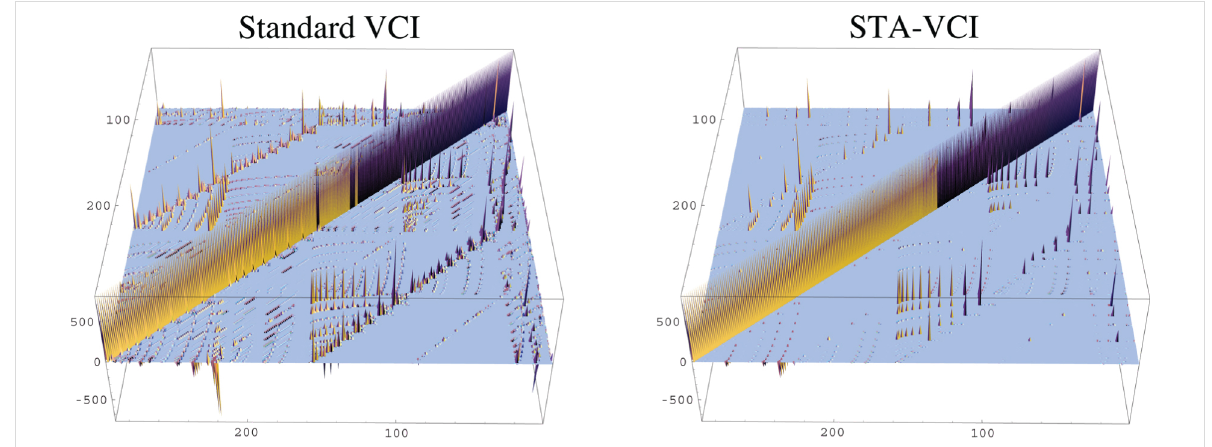
Figure 5: Graphical representation of the VCI matrix elements for a standard VCI and a STA–VCI calculation on methanol using the same basis. For the STA–VCI method, the OH-stretch mode is coupled to all other modes ( N Ã = 1). Note the difference in the occurrence of off-diagonal elements between standard VCI and STA–VCI.